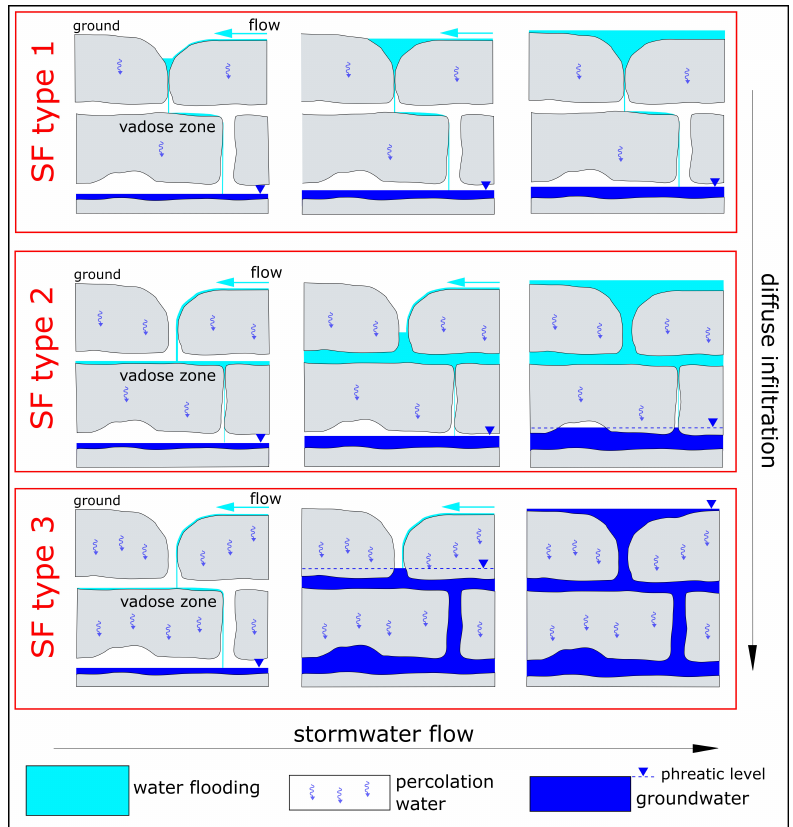
Figure 1. Simplified scheme of SF types. It is not representative of the whole complexity of the phenomenon and simply considers change in width of the karst shafts. The increase in diffuse infiltration from SF type 1 to SF type 3 is a generic